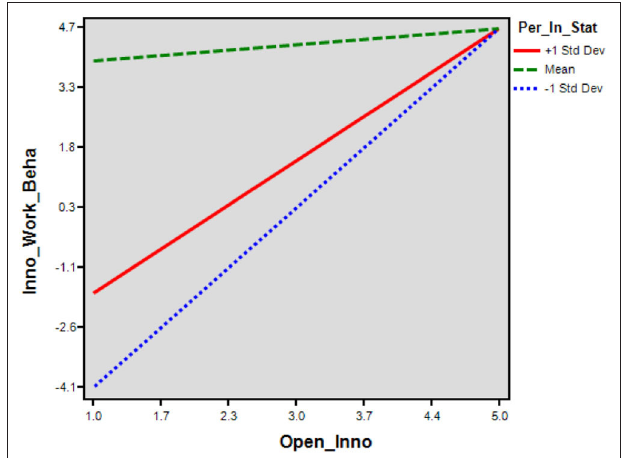
FIGURE 4 | Indirect effects. Source: generated through interaction software.